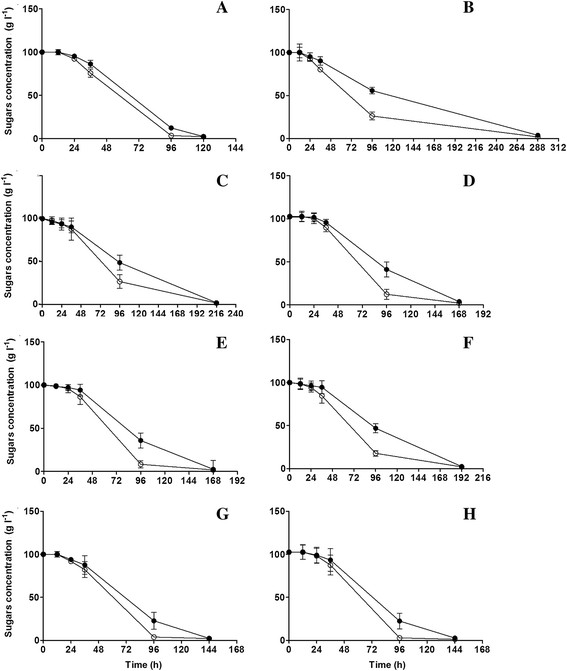
Glucose (○) and fructose (●) consumption profiles compared for the 8 yeast strains QA23 (A), VL1 (B), CEG (C), BRL97 (D), XL (E), T73 (F), NT116 (G) and UCD522 (H) in the media supplemented with high nitrogen (670 mg l
−1
).